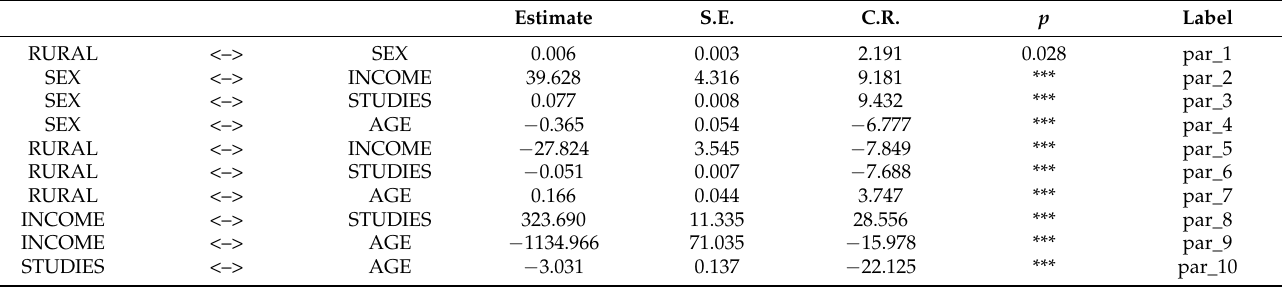
Table A21. Covariances: (Group number 1-Default